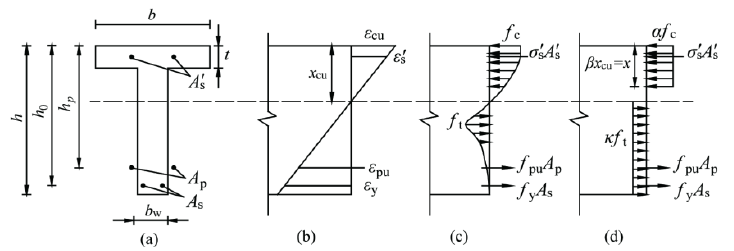
Figure 14. Stress–strain distribution at ultimate state: ( a ) cross section drawing; ( b ) strain distribution; ( c ) actual stress distribution; ( d ) simplified triangular stress distribution.